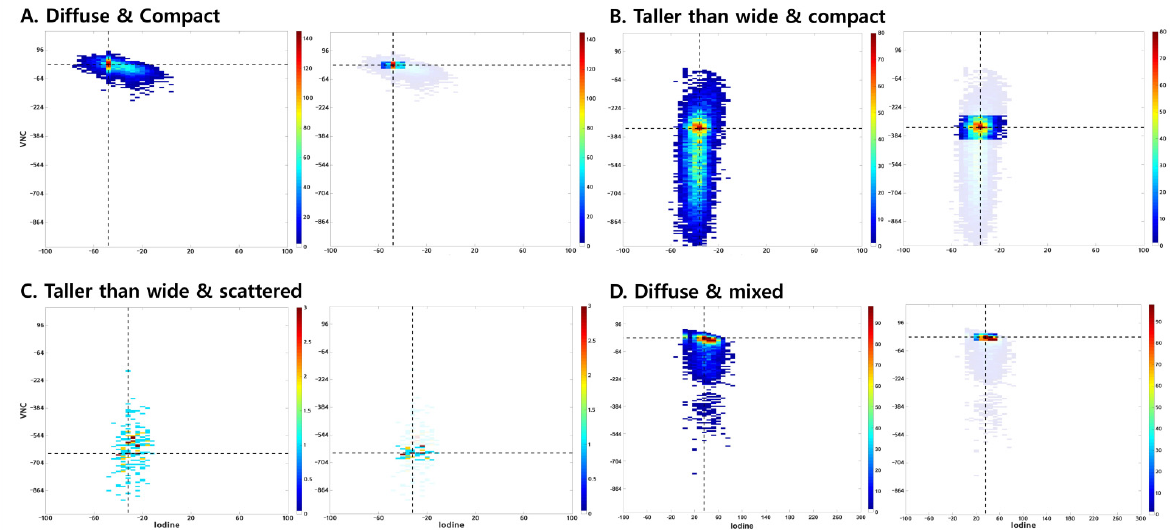
Figure 1. Joint histogram of VNC and iodine map. ( A ) A 62-year-old male patient with solid predominant type invasive adenocarcinoma. The joint histogram graph is shown on the left with the transverse axis as iodine histogram attenuation scale and the longitudinal axis as VNC histogram scale. The shape of intensity value pairs is diffuse, and the distribution is compact. The VNC group is within the high group. On the right, the graph shows the localized area that contains 30% of the total distribution around the cross-point value (area 30). Area 30 is compact. ( B ) A 62-year-old male patient with pure-acinar type invasive adenocarcinoma. The shape of the intensity value pairs is taller than wide, and the distribution is compact. The VNC group is within the intermediate group, and area 30 is diffuse. ( C ) A 62-year-old female patient with pure-lepidic type adenocarcinoma in situ (AIS). The shape of intensity value pairs is taller than wide, and the dis- tribution is scattered. The VNC group is within the low group and area 30 is diffuse. ( D ) A 46-year-old male with papil- lary-predominant type invasive adenocarcinoma. The shape of intensity value pairs is diffuse, and the distribution is mixed. The VNC group is within the high group, and area 30 is compact.